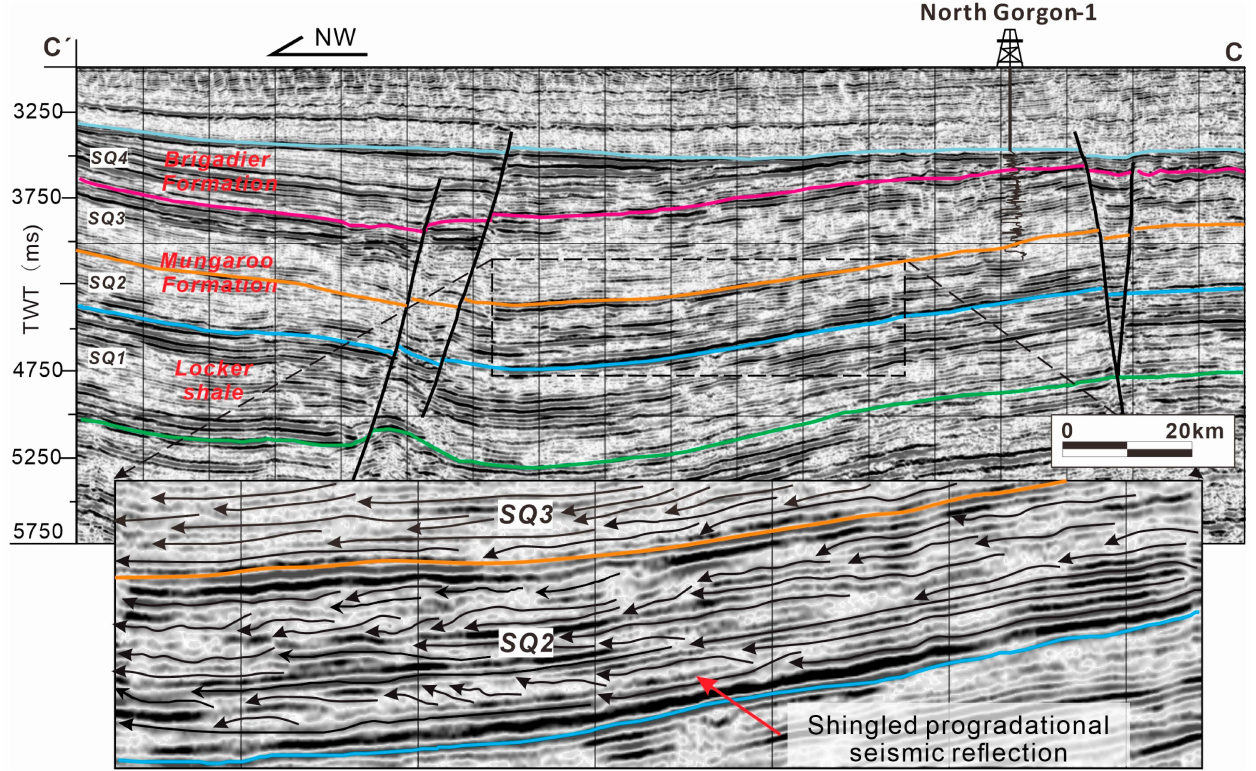
Figure 7. Cross-well seismic profile C–C (cid:48) presents a typical progradational seismic reflection of the SQ2 and SQ3. See Figure 1a for the position of the seismic profile C–C (cid:48) . Abbreviation: TWT = two-way travel